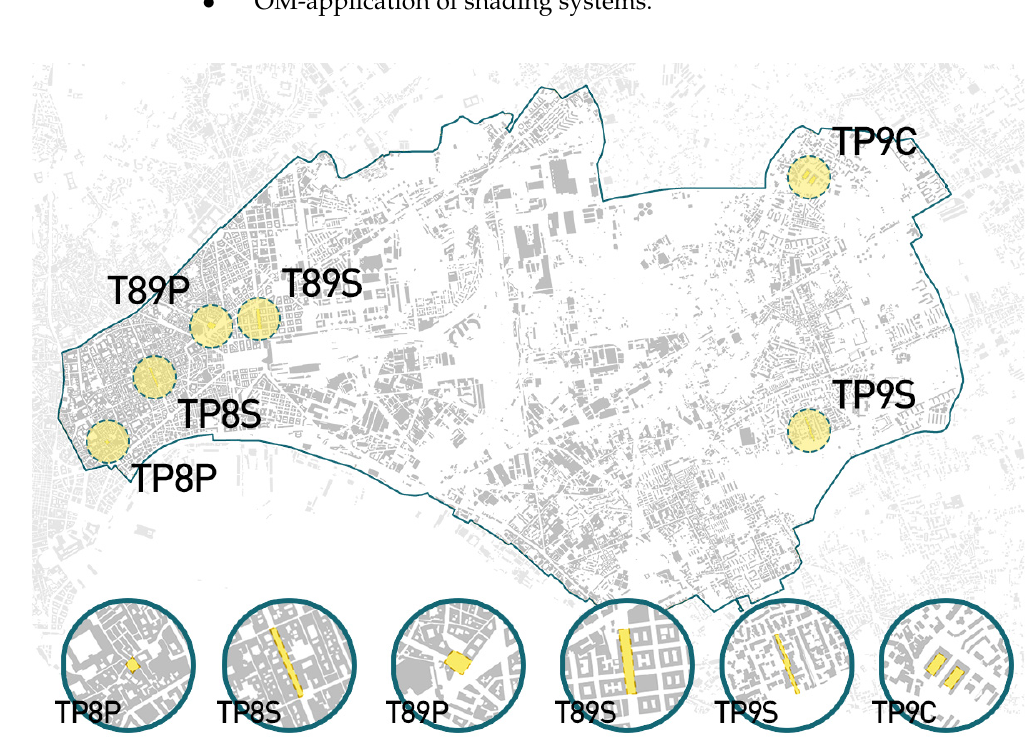
Figure 10. Identification of spaces for testing operations.